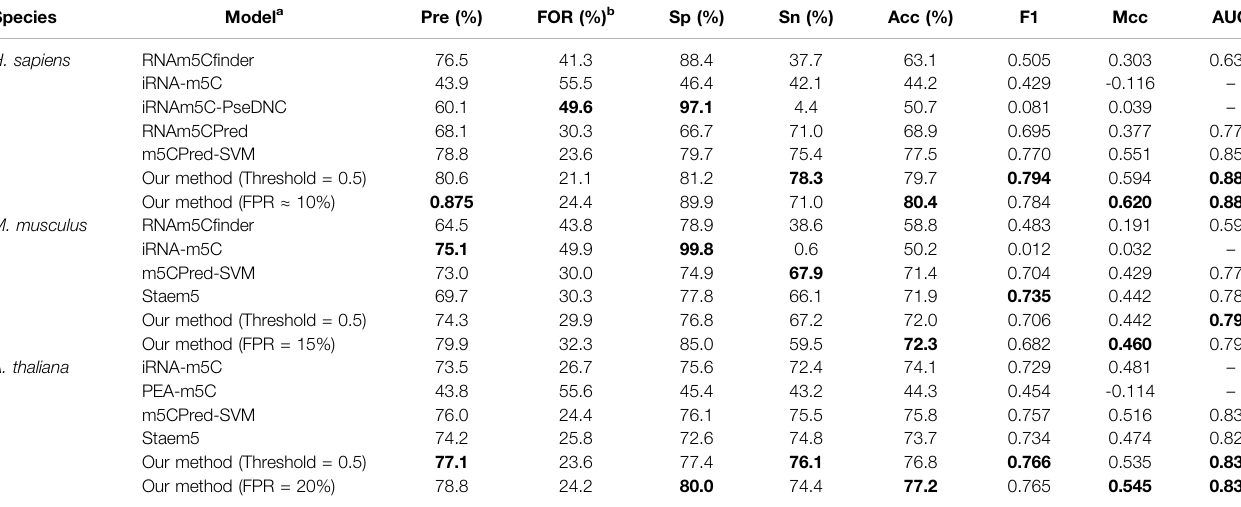
TABLE 6 | Comparison with other existing models on the independent test sets. Species Model a